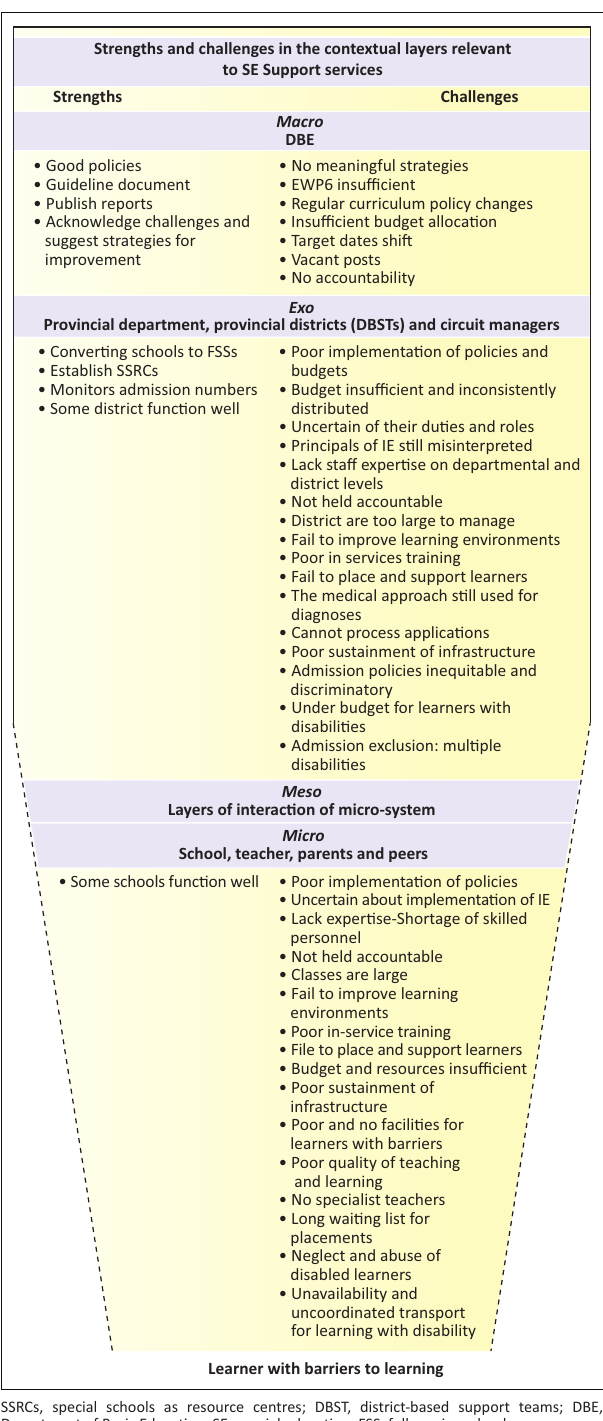
FIGURE 2: Learner with barriers to